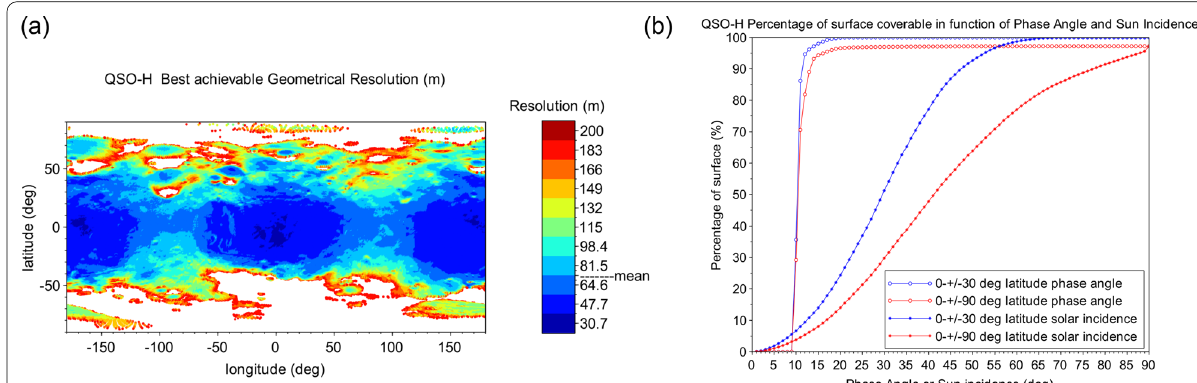
Fig. 6 a Coverage and geometric (spatial) resolution of MIRS mapping from QSO‑H in Oct 2025 ( β 10°). The resolution at equator is better than = high latitude regions because QSO‑H is on the equatorial plane. Areas in white cannot be observed because of spacecraft’s equatorial trajectory and Phobos flat shape on the poles. Areas with the spatial resolution above 200 m are not displayed. Note that the map was calculated without considering the masking of facets by local topology: areas with longitude around 150° and 150° and latitude 80° as well as the areas with − − longitude around 150° and latitude 80° are actually masked and cannot be observed. Percentage of surface covered at resolution better than 100 m is 98% for areas within 30° latitudes and 73% for all areas, at resolution better than 40 m is 28% for areas within 30° latitudes and 16% for all ± ± areas, and at resolution better than 30 m is 0% for areas within 30° latitudes and 0% for all areas. b Percentage of Phobos surface covered as a ± function of phase and sun incidence angles with observation in a . Blue lines indicate percentages for surface within 30° latitudes, while red lines ± for whole